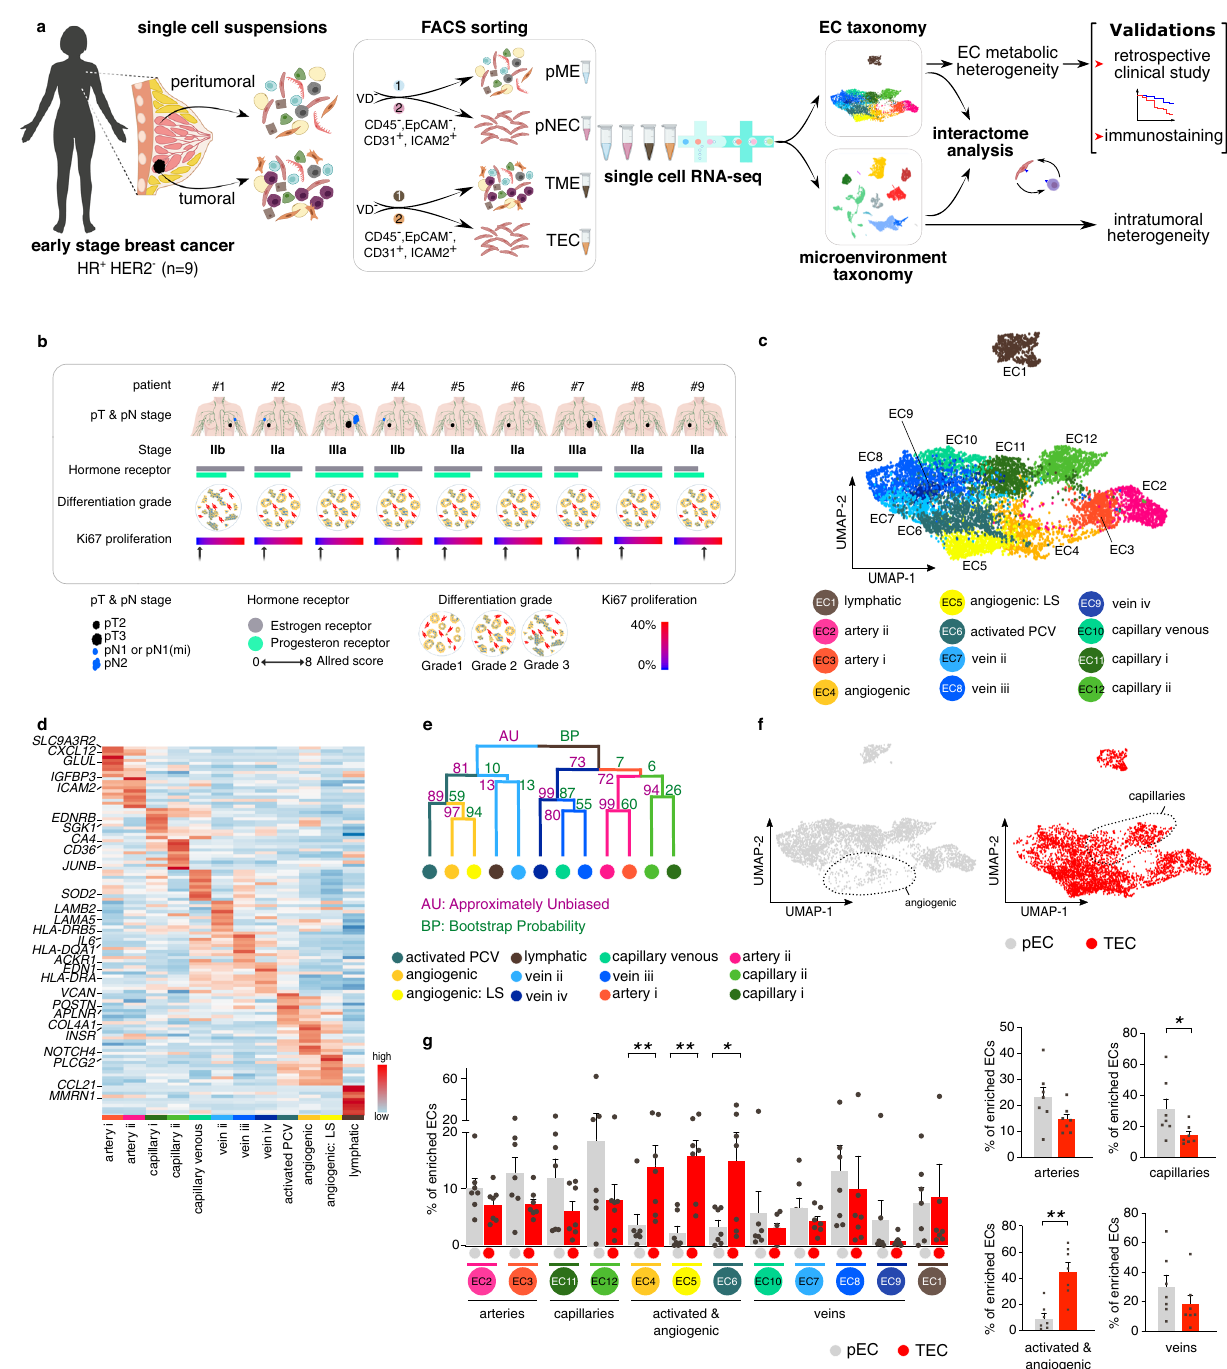
AU: Approximately Unbiased BP: Bootstrap